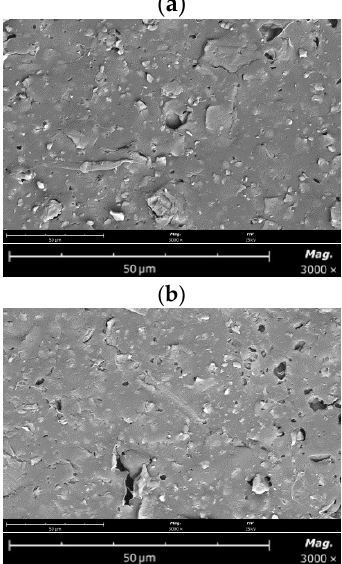
Figure 4. Images of the top surface of the membranes (before biofouling) obtained by SEM: ( a ) un- modified AEM; ( b ) modified AEM.